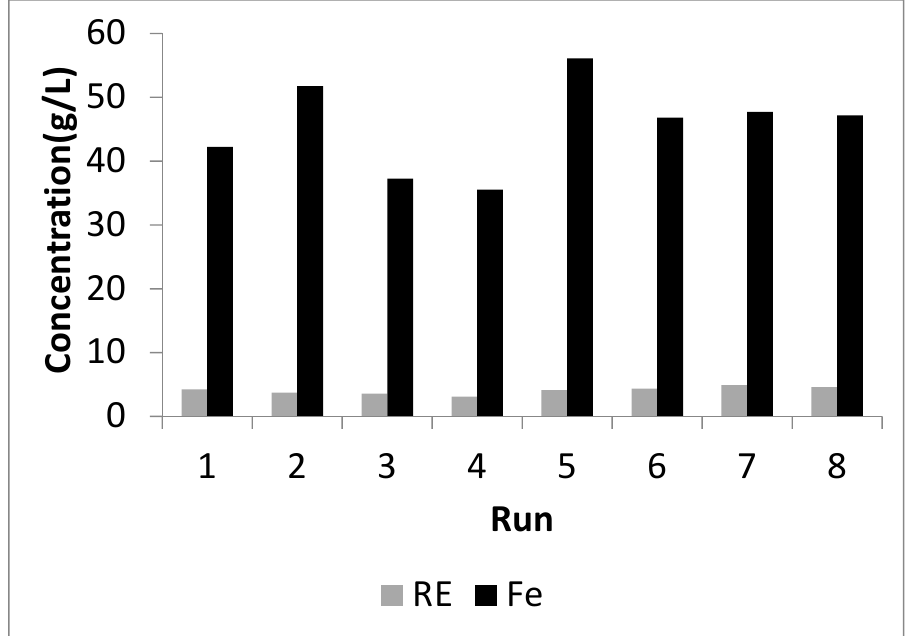
Figure 6. REE (RE) and iron (Fe) concentration (g/L)—screening experiments.